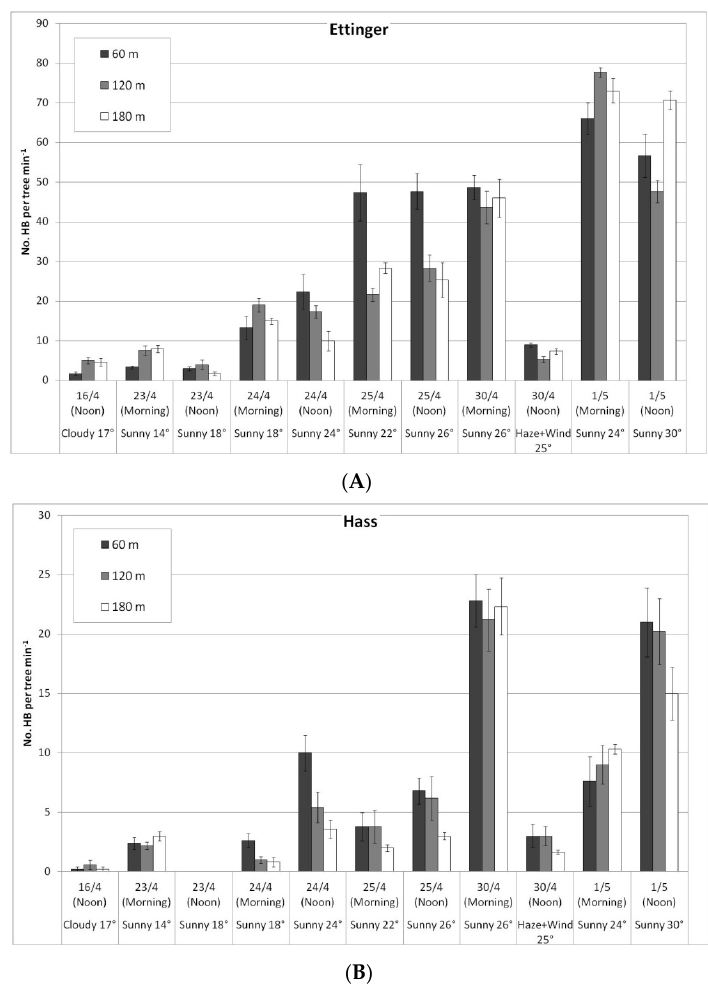
Figure 4. Daily number of honeybees (HBs) on ‘Ettinger’ ( A ) and ‘Hass’ ( B ) trees at three distances from the bumblebee (BB) hives (60, 120, and 180 m), Kfar Giladi, April 2019. Data are means of five trees at each distance ± SE.